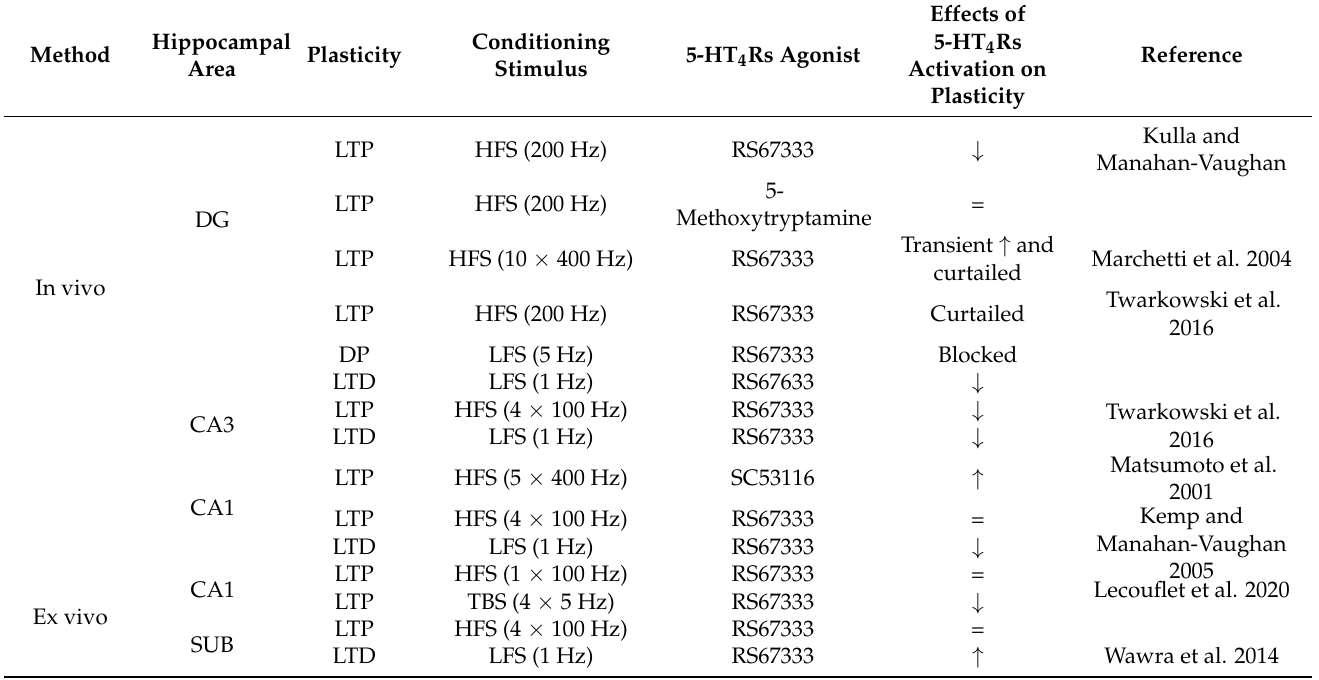
Table 2. Compilation of electrophysiological investigations of synaptic plasticity in rodents after pharmacological 5-HT 4 Rs activation. ↑ denotes an increase; ↓ denotes a decrease; = denotes no change. Abbreviations: CA1, CA3: cornus ammonis 1,3; DG: dentate gyrus; DP: depotentiation; HFS: high frequency stimulation; LTD: long term depression; LTP: long term potentiation; LFS: low frequency stimulation; SUB: subiculum; TBS: theta burst